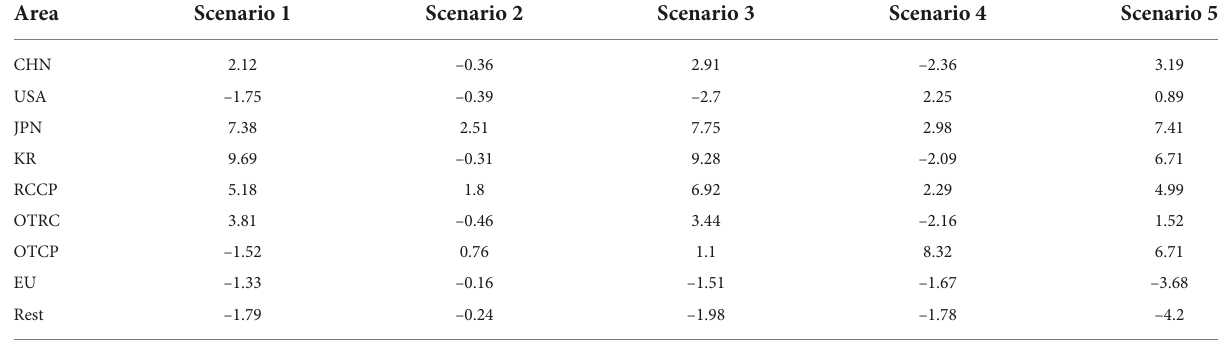
TABLE 4 Impact on gross domestic production (GDP) (%).